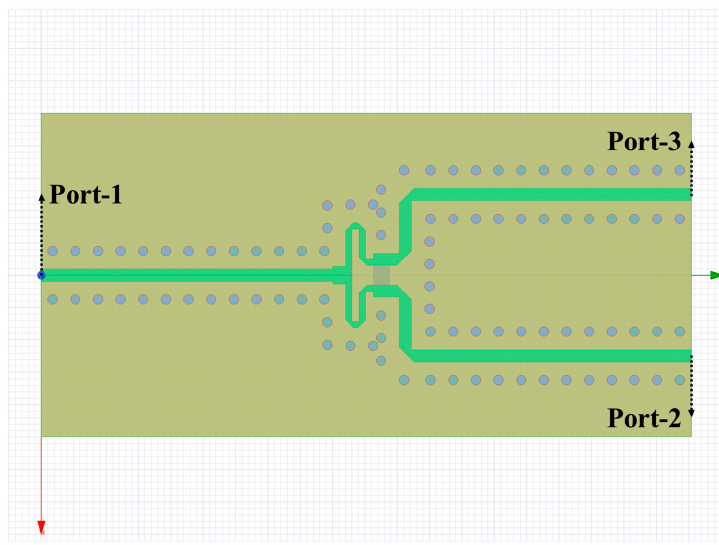
Figure 6. LTCC-based stripline 2-way power divider for Ku-band.